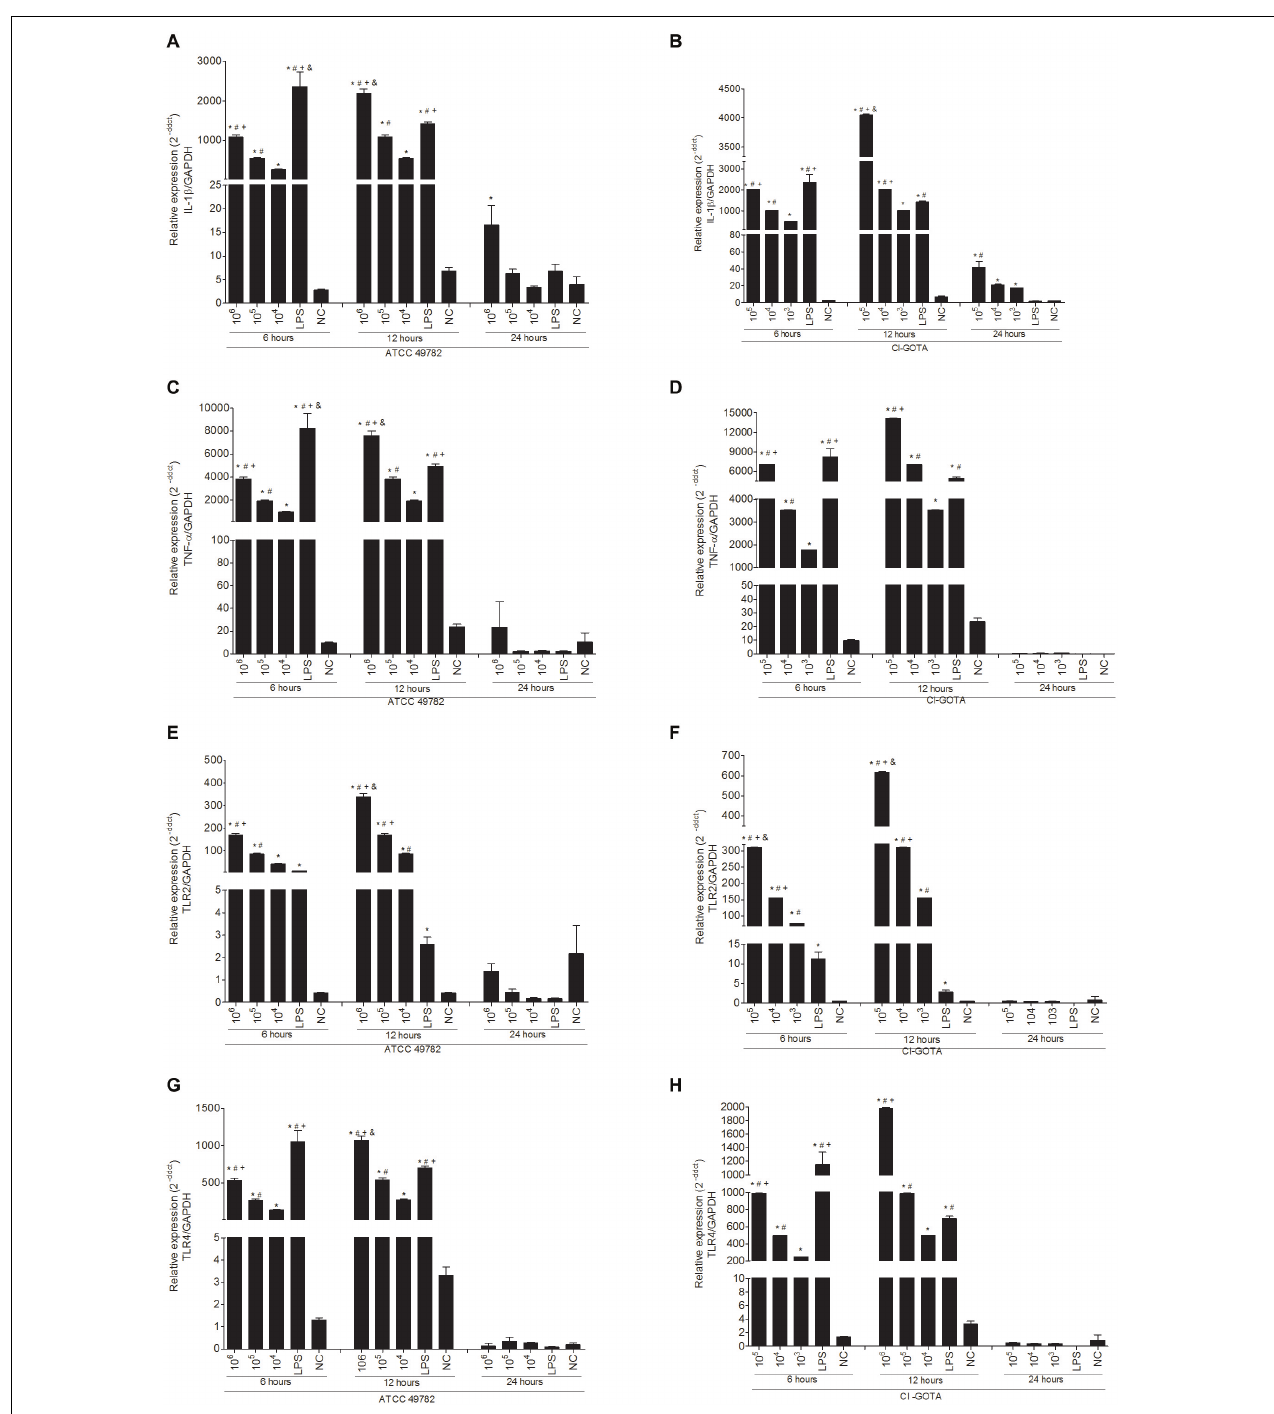
FIGURE 2 | Gene expression in bovine macrophages infected with different Ureaplasma /mL of ATCC 49782 and CI-GOTA strains for 6, 12, and 24 h. (A) IL-1 β expression in macrophages inoculated with the ATCC 49782 strain. (B) IL-1 β expression in macrophages inoculated with the CI-GOTA strain. (C) TNF- α expression in macrophages inoculated with ATCC 49782 strains. (D) TNF- α expression in macrophages inoculated with CI-GOTA strain. (E) TLR2 expression in macrophages inoculated with ATCC 49782 strains. (F) TLR2 expression in macrophages inoculated with the CI-GOTA strain. (G) TLR4 expression in macrophages inoculated with ATCC 49782 strains. (H) TLR4 expression in Macrophages inoculated with CI-GOTA strain. Treatments were compared using the Kruskal–Wallis non-parametric test followed by the Dunn post-test. PBS - negative control (CN) and 100 ng/mL of LPS was used as positive control. Statistical significance ( p < 0.05) is represented by the symbols Statistical significance ( p < 0.05) is represented by the symbols [ ∗ difference with the NC group, # difference with the LPS group, + difference with the 10 5 group (ATTC) or 10 4 group (CI-GOTA), & difference with the 10 4 group (ATTC) or 10 3 group (CI-GOTA)]. Data are expressed as mean ± standard deviation ( n = 9).